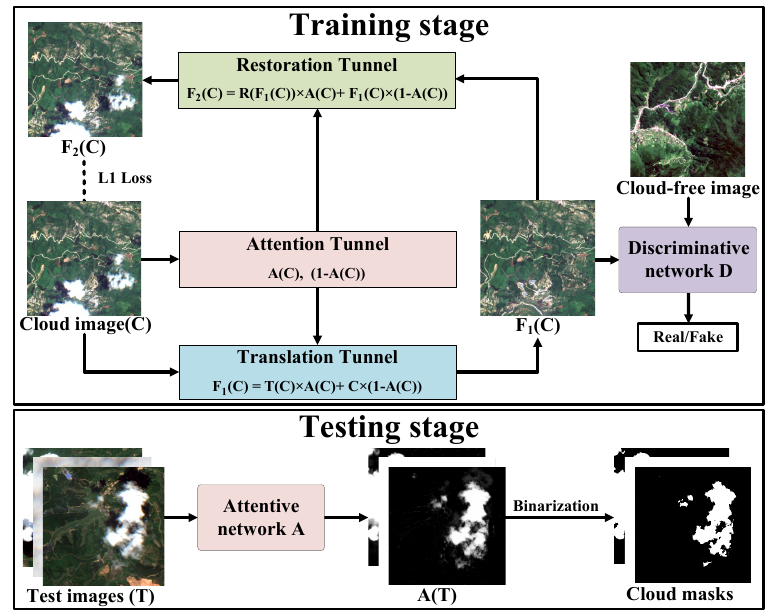
Figure 1. Flowchart of cloud detection based on